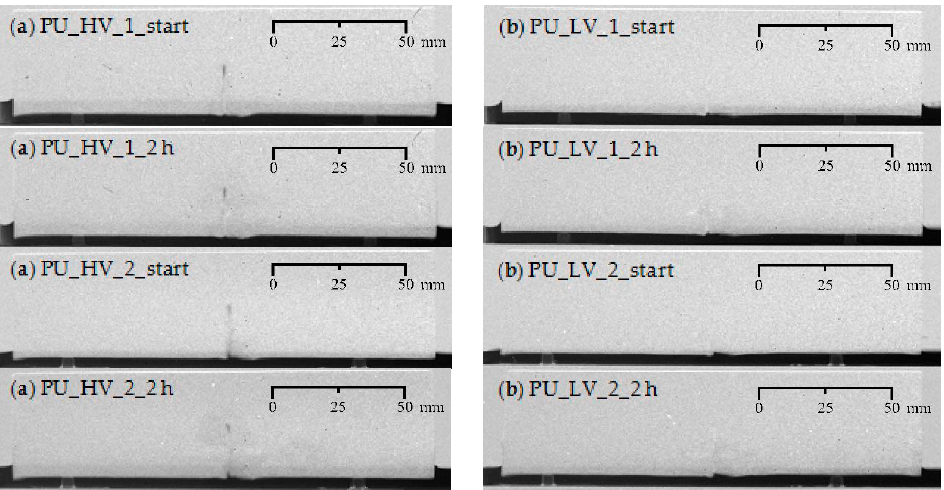
Figure 24. Visualization of the water uptake as a function of exposure time using neutron radiography for four mortar prisms immediately after release of the PU-based healing agent: ( a ) crack healing with PU_HV (specimens: PU_HV_1-2); and ( b ) crack healing with PU_LV (specimens: